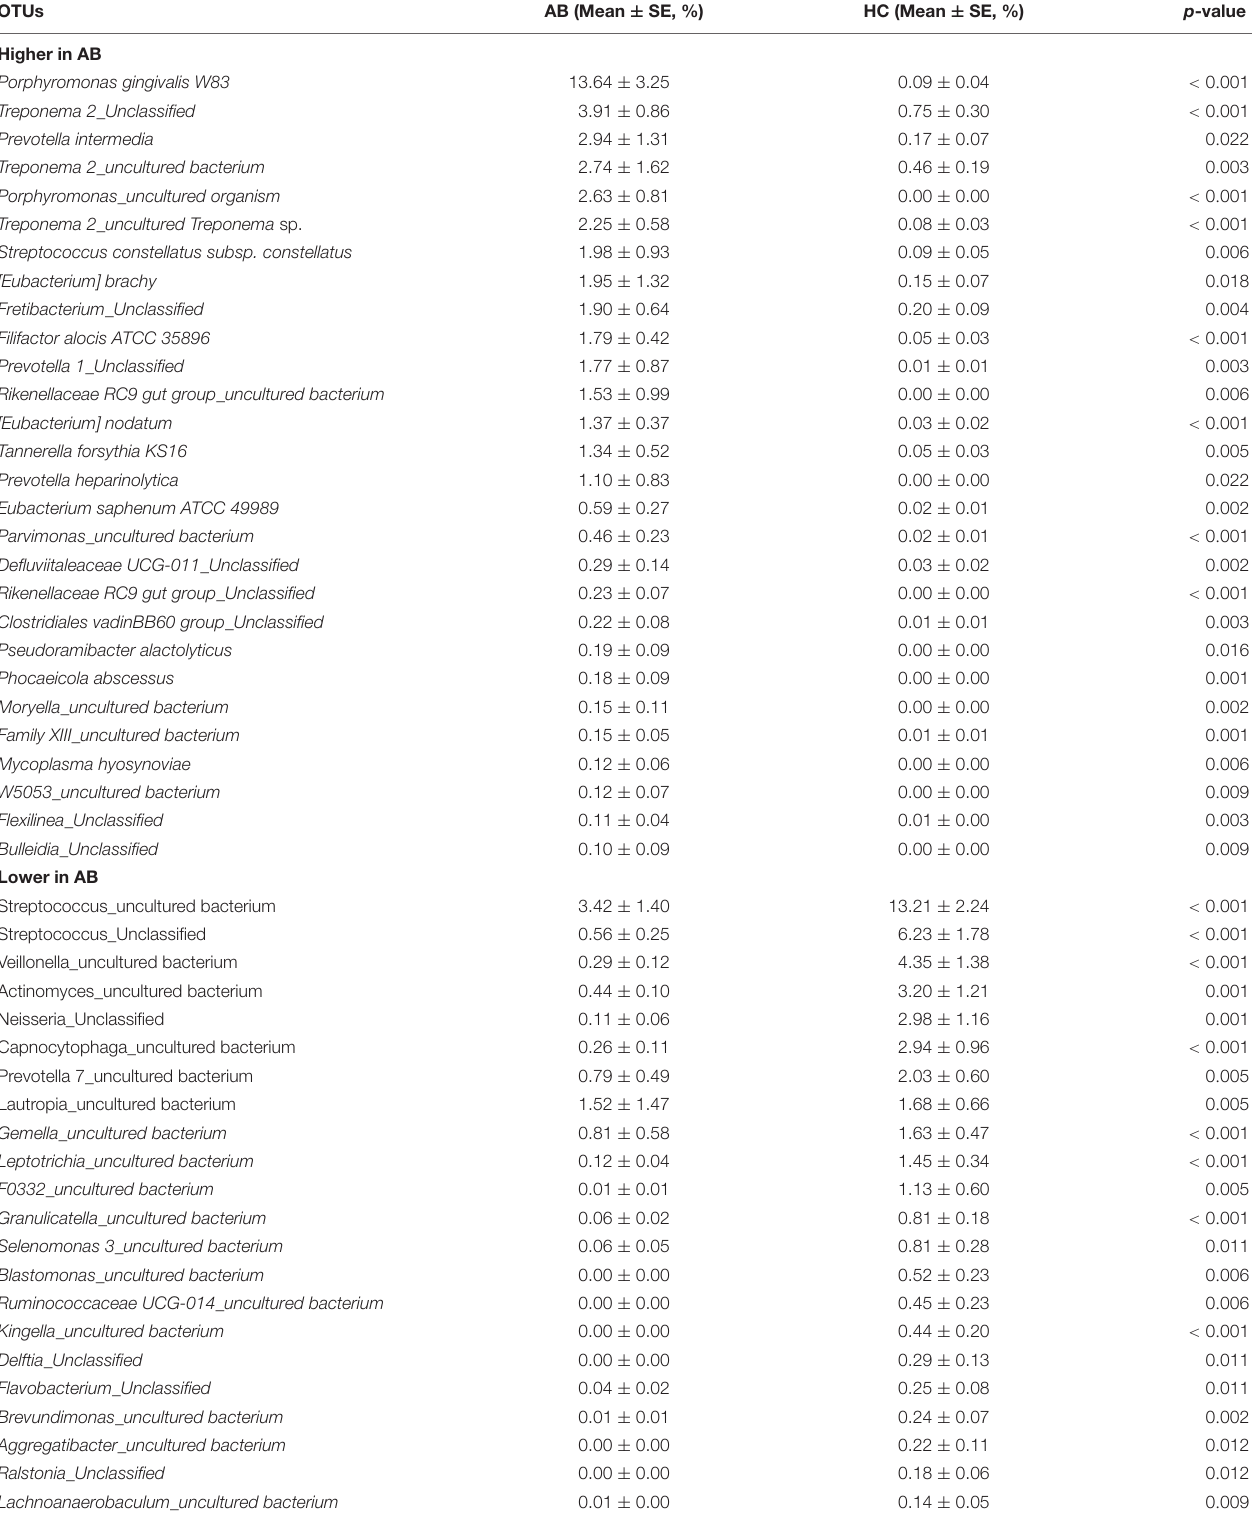
TABLE 4 | Mean relative abundance of OTUs with significant statistical difference between AB and HC groups at group level. OTUs AB (Mean ± SE,